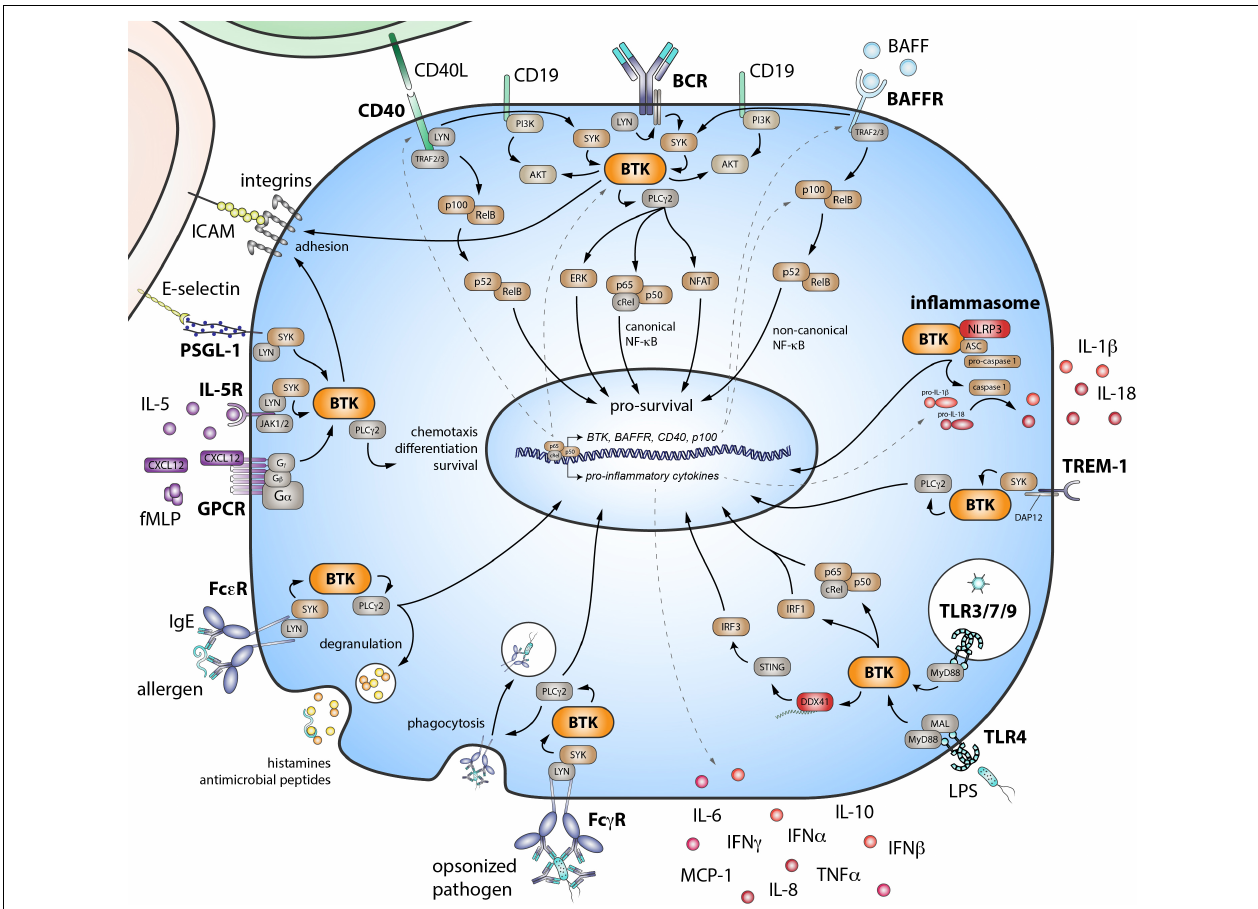
FIGURE 1 | Role of Bruton’s tyrosine kinase (BTK) in various signaling pathways in B cells and myeloid cells. BTK is critical downstream of the B cell receptor (BCR). The BAFF receptor (BAFFR) transduces signals by coopting the BCR. The co-stimulatory receptor CD40 also signals via both the noncanonical NF- κ B pathway and BTK. Eventually, these signaling pathways lead to the activation of downstream transcription factors—important for survival, differentiation, proliferation, and cytokine production of B cells. BTK also functions in inflammasome activation and in signaling downstream pattern recognition receptors, including triggering receptor expressed on myeloid cells 1 (TREM-1) and the Toll-like receptor (TLR) family. Activating Fc γ Rs via BTK signaling, can stimulate cells to initiate cytokine production, phagocytosis, and microbicidal activity of engulfed pathogens. Fc ε Rs can bind IgE and are mostly expressed on mast cells and basophils. When cross-linked, these receptors also signal via BTK, resulting in the quick release of histamines and antimicrobial peptides via degranulation. BTK is also involved in downstream signaling of G-protein coupled receptors (GPCR), such as chemokine and cytokine receptors. E-selectin–driven engagement of PSGL-1 induces downstream signaling via BTK to activate integrins. SYK, spleen tyrosine kinase; PLC γ 2, phospholipase C γ 2; PI3K, phosphoinositide 3-kinase; ERK, extracellular signal-regulated kinase; NF- κ B, nuclear factor- κ B; TRAF, tumor necrosis factor receptor-associated factor; BAFF, B cell activating factor of the tumor necrosis factor superfamily; NLRP3, NLR family pyrin domain containing 3; ASC, apoptosis-associated speck like protein containing a caspase recruitment domain; DAP12, DNAX activation protein of 12 kDa; MyD88, myeloid differentiation primary response 88; MAL, MyD88 adaptor-like; IRF, interferon regulatory factor; DDX41, DEAD-box helicase 41; STING, stimulator of interferon genes; IL, interleukin; IFN, interferon; MCP-1, monocyte chemoattractant protein-1; TNF α , tumor necrosis factor α ; Fc γ R, Fc γ receptor; Fc ε R, Fc ε receptor; fMLP, N-Formylmethionyl-leucyl-phenylalanine; CXCL12, C-X-C-motif chemokine ligand 12; JAK, Janus kinase; PSGL-1, P-selectin glycoprotein ligand-1; ICAM, intercellular adhesion